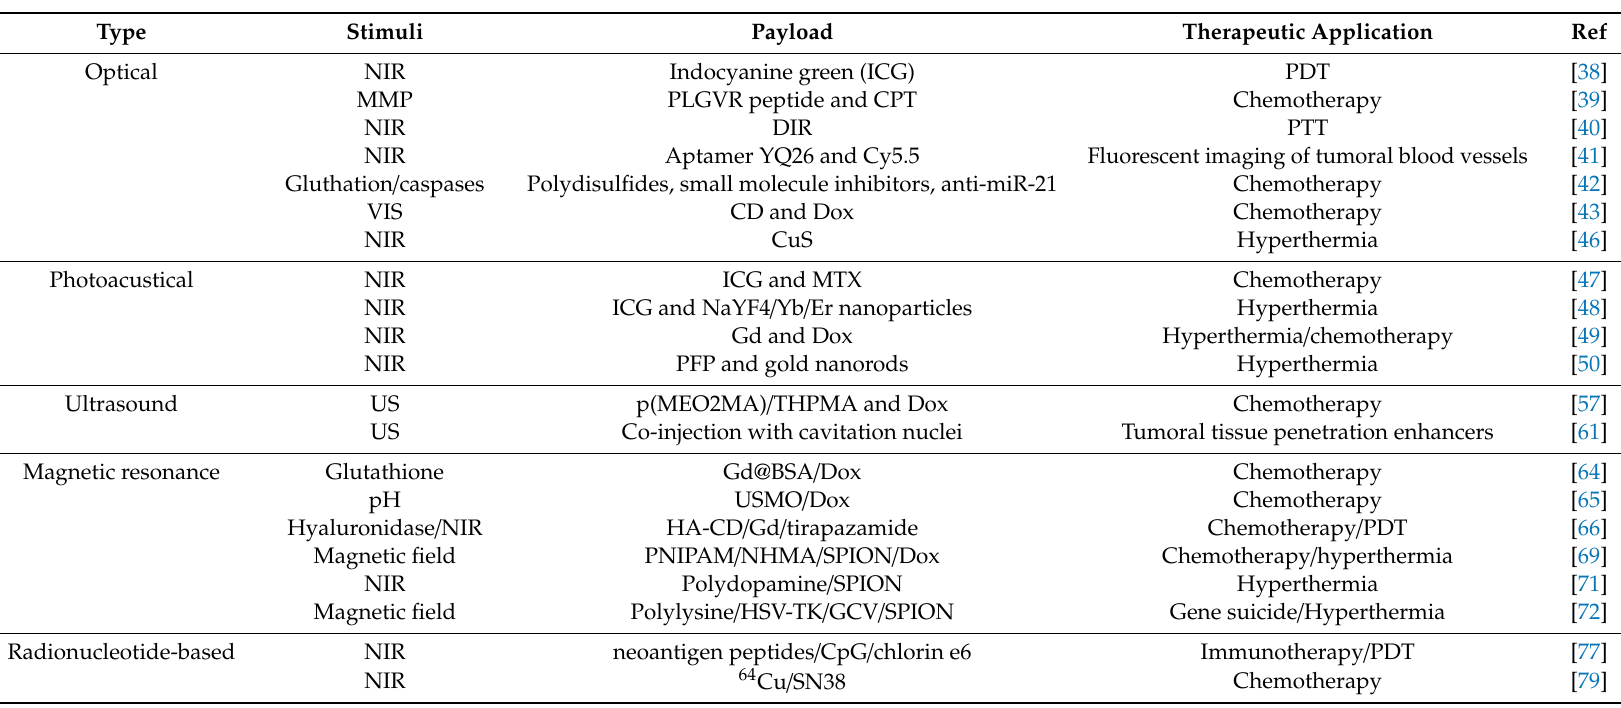
Table 1. Summary of the di ff erent theranostics MSN according with the imaging technique, payload, and stimuli which trigger the therapeutic